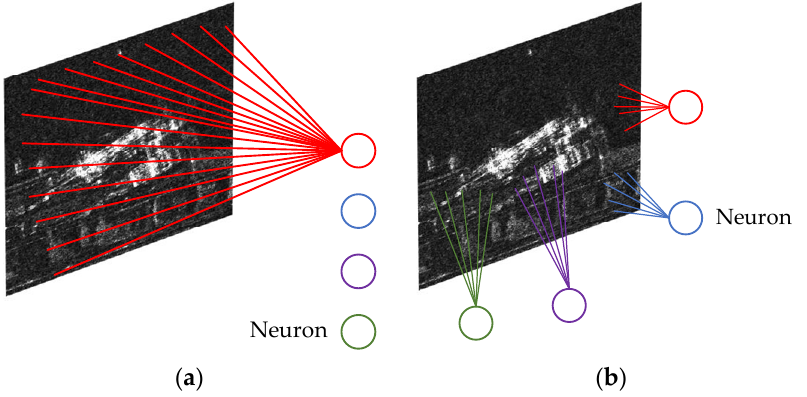
Figure 4. Fully connected and locally connected: ( a ) Fully connected sketch map; ( b ) Locally connected sketch map. connected sketch map.